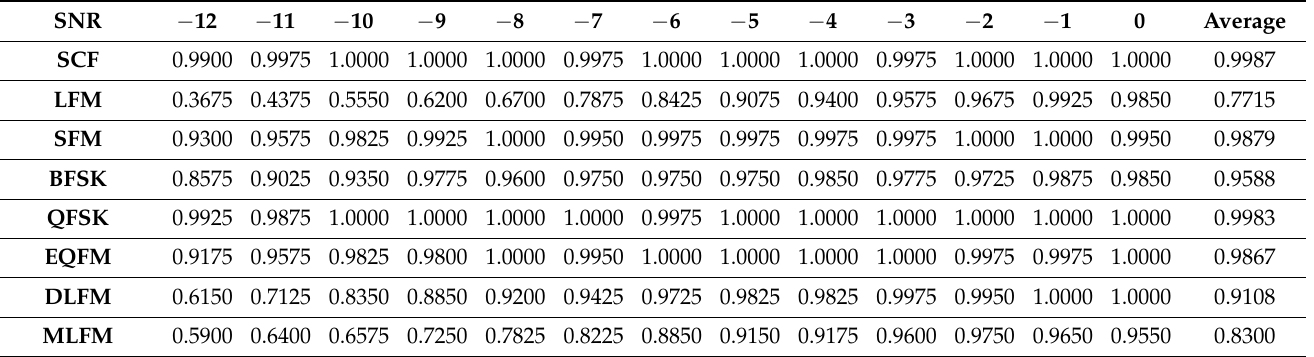
Table A27. The fully supervised classification results with the datasets in Situation Dataset